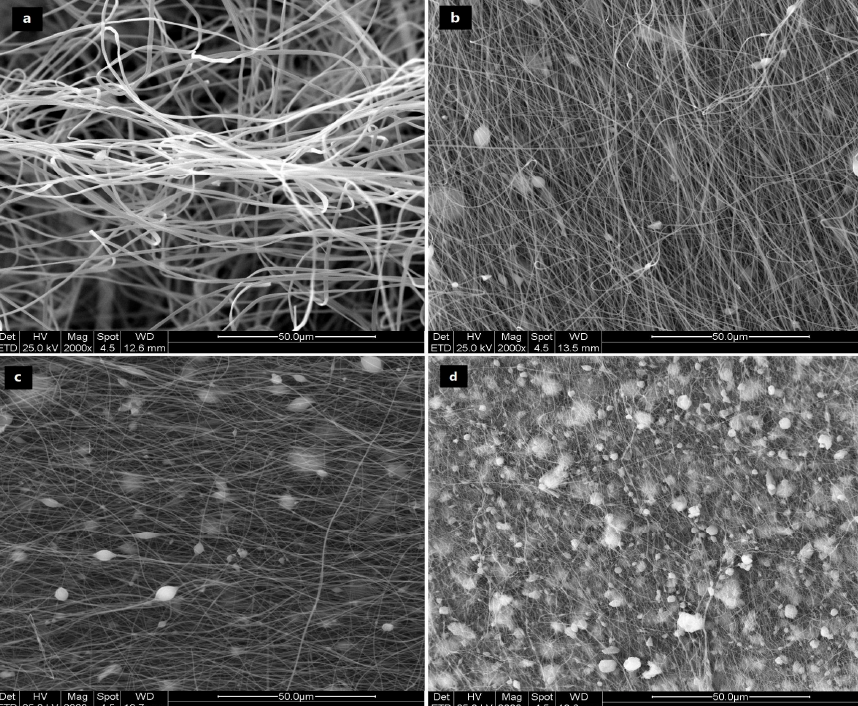
Figure 5. ESEM imaging of the “as-spun” fibers: ( a ) 100% PAN; ( b ) 90% PAN-10% biochar; ( c ) 75% PAN-25% biochar; ( d ) 50% PAN-50% biochar.